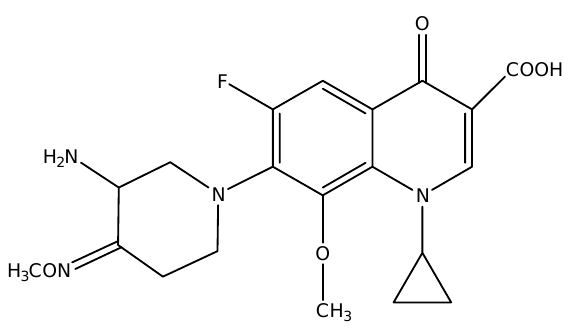
Figure 1. New 8-methoxylfluoroquinolone